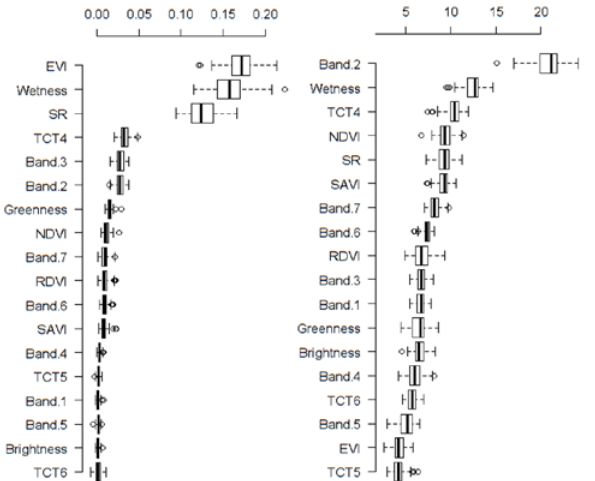
Figure 3: Variable importance of LAI models cforest (left) rforest (right)